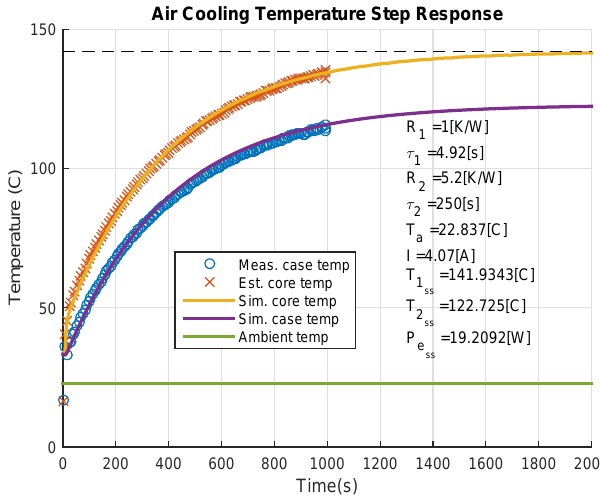
Figure 8. Thermal step response of the Maxon EC22 100-W motor with air cooling. A current amplitude of 4.07 A was used. This amplitude was empirically determined and causes the core motor temperature to reach an estimated steady-state value of 141.9 ◦ C (a safety margin of 13.1 ◦ C compared to the maximum rated value of 155 ◦ C). The core temperature was estimated using the thermal control technique described in Section 2.2. Actual data are plotted as points, while the lines are simulated responses and were used to fit the thermal model (from Figure 1b) to the